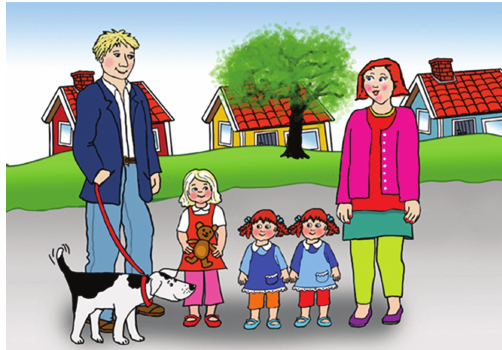
Figure 2: Sara’s second family. Illustrations by Gunilla